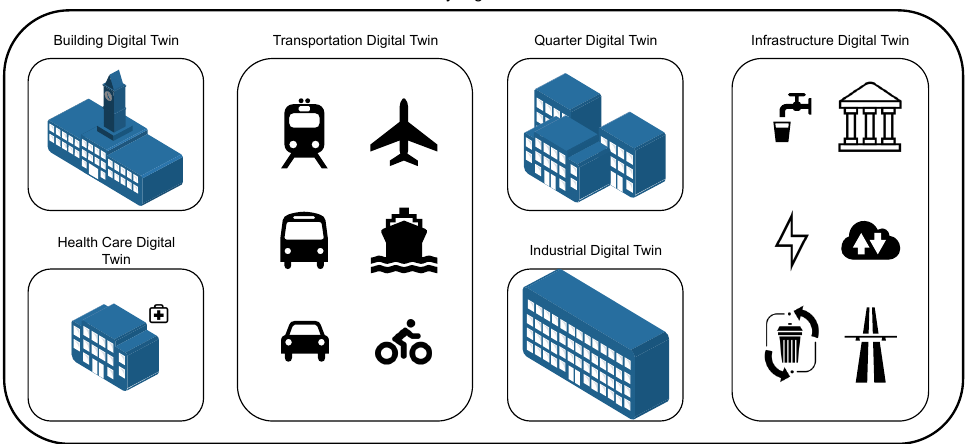
Figure 4. Composition of Digital Twins to describe higher order complex systems. Multiple DTs are composed into higher order systems such as cities. Here, an open stationary city DT is composed of different open or closed and mobile or stationary DTs such as building DTs, transportation DTs, and infrastructure DTs. Each of the DTs contains complex nested DTs of different types such as for healthcare or industrial settings. The complexity level can be arbitrarily increased through nesting. Generated with